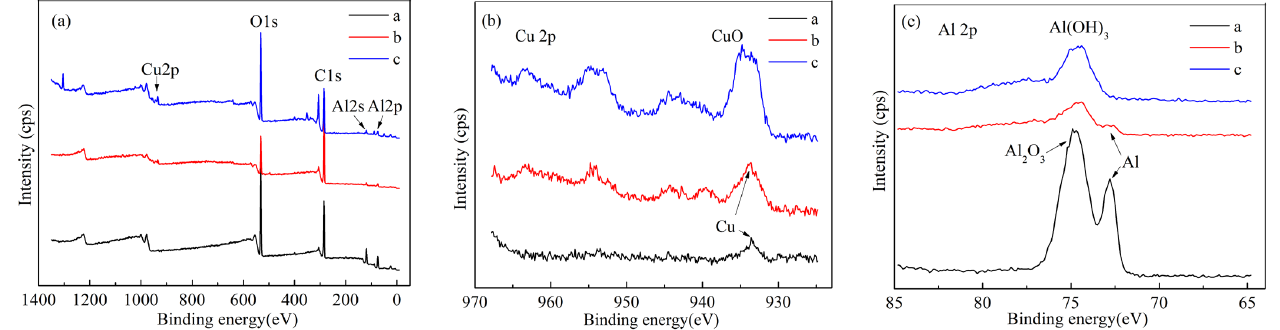
Figure 4. XPS spectra of ( a ) untreated aluminum alloy, ( b ) stearic-acid-treated aluminum alloy after Na 2 CO 3 etching and ( c ) stearic-acid-treated aluminum alloy after NaOH-etching at 90 °C.